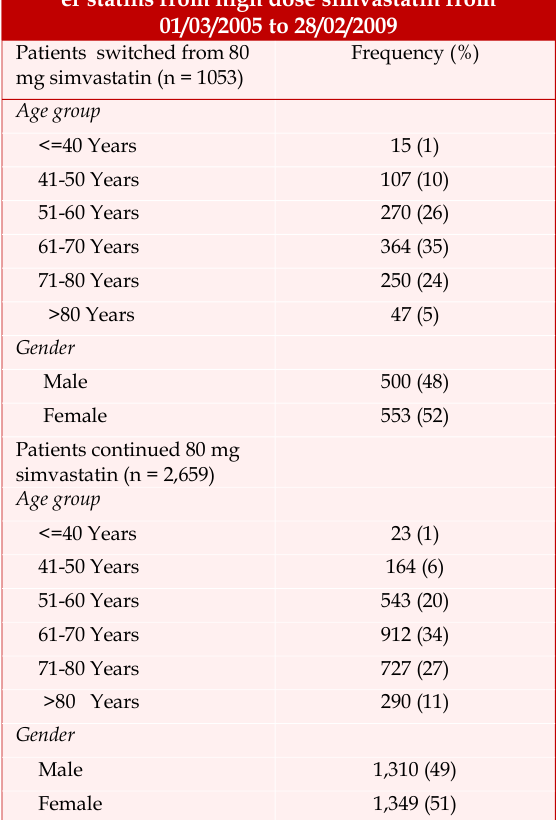
Proportion of female and male patients and their age group in Scotland those were Switched to oth- er statins from high dose simvastatin